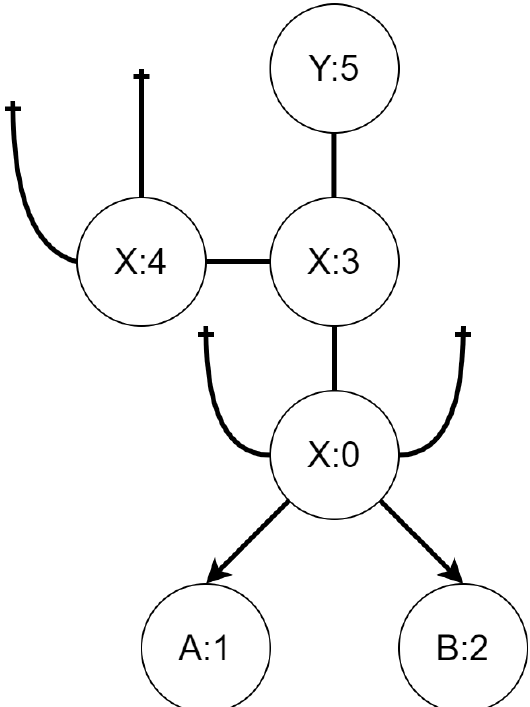
Figure 5. Initial state of the system modeled in scenario 1. X and Y are different types of areas, while A and B are different kinds of